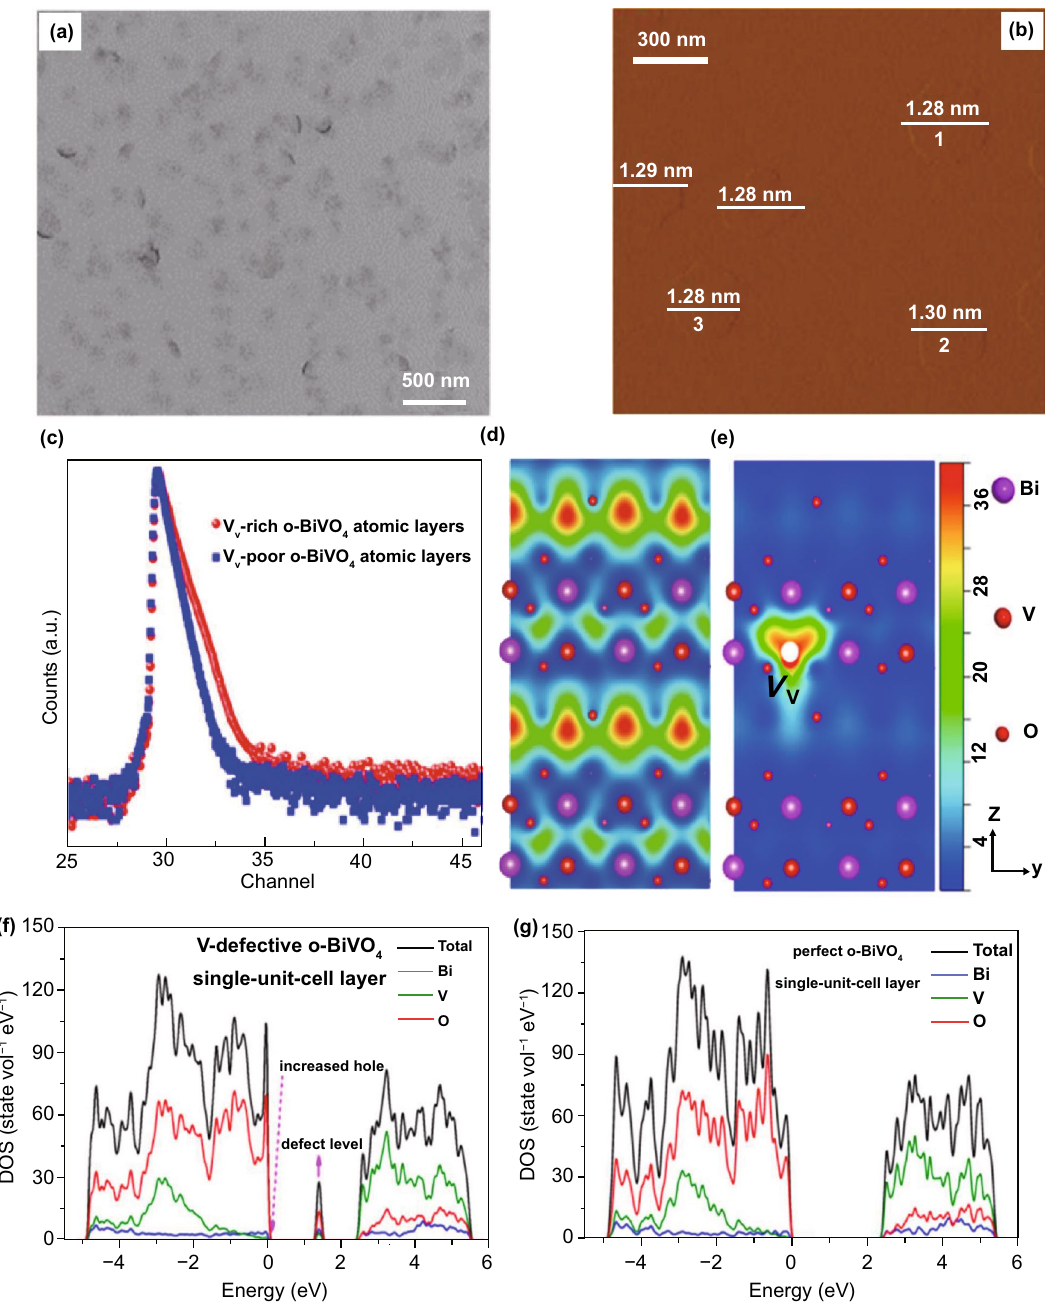
Fig. 13 a , b TEM and AFM analysis of one‑unit‑cell thickness Vv‑rich o‑BiVO 4 . C–e Defects study of V v ‑rich and V v ‑poor o‑BiVO 4 atomic layers. c Positron duration spectra. d , e Scheme of entrapped positrons. f , g DOSs calculation of the V defects in o‑BiVO 4 single‑unit‑cell layer slab and pure o‑BiVO 4 single‑unit‑cell layer slab ( f ), along [001] direction ( g ). Adapted with permission from Ref.